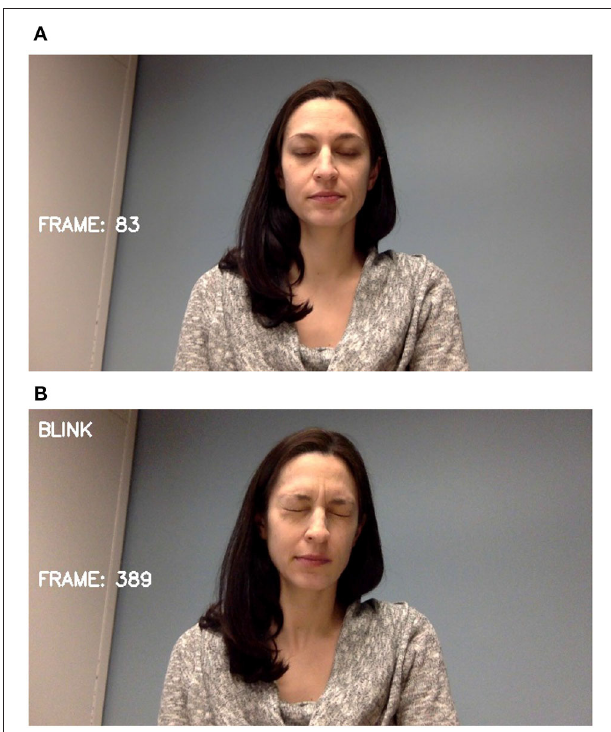
FIGURE 4 | Stills from video of co-author: (A) blinking normally, (B) mimicking tic